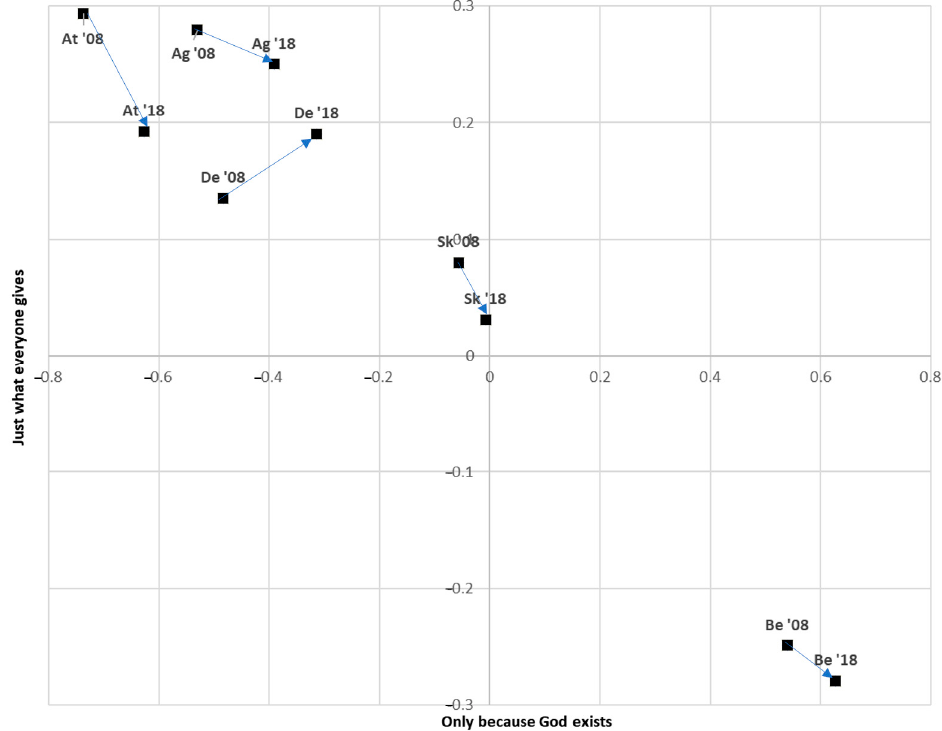
Figure 2. Religious options according to the importance of the meaning of life in God or each other (At = Atheist; Ag = Agnostic; De = Deist; Sk = Skeptic believer; Be = Believer). (At = Atheist; Ag = Agnostic; De = Deist; Sk = Skeptic believer; Be =